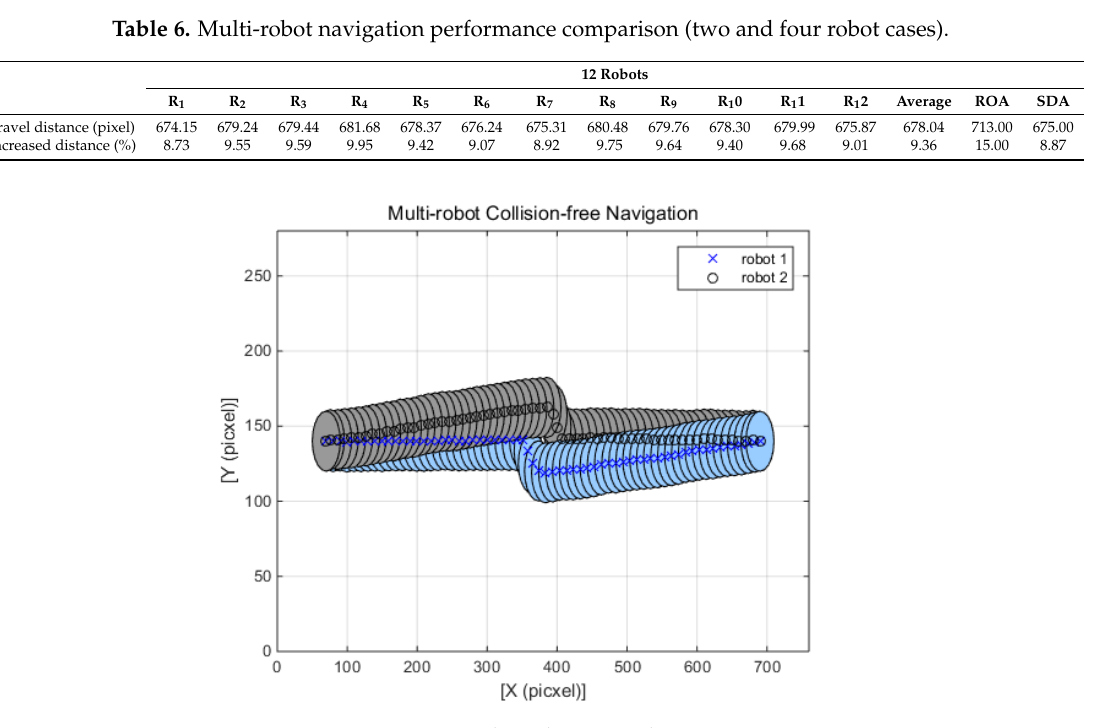
Figure 7. FAHP-CGT algorithm two robot